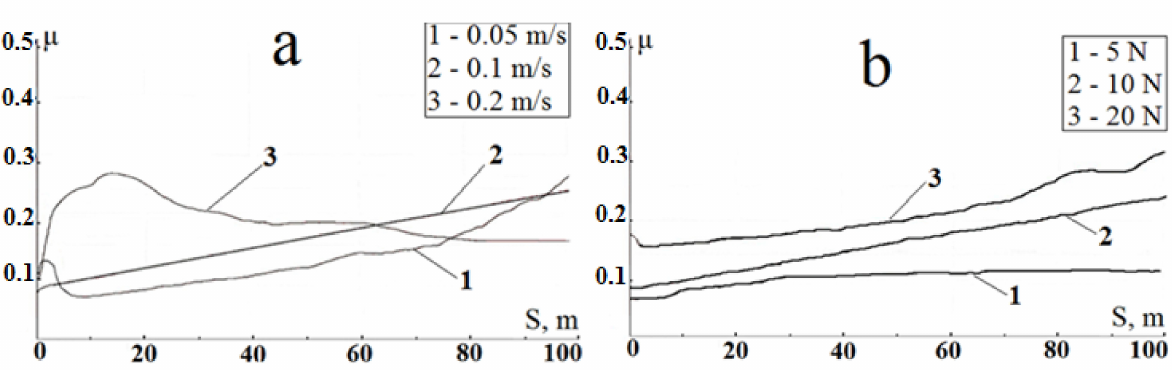
Figure 10. Friction coefficient as a function of sliding distance during the test treated samples: ( a ) at constant load of 10 N and variable sliding velocities 0.05, 0.1, and 0.2 m/s, ( b ) at constant sliding velocity of 0.1 m/s and variable load 5, 10, and 20